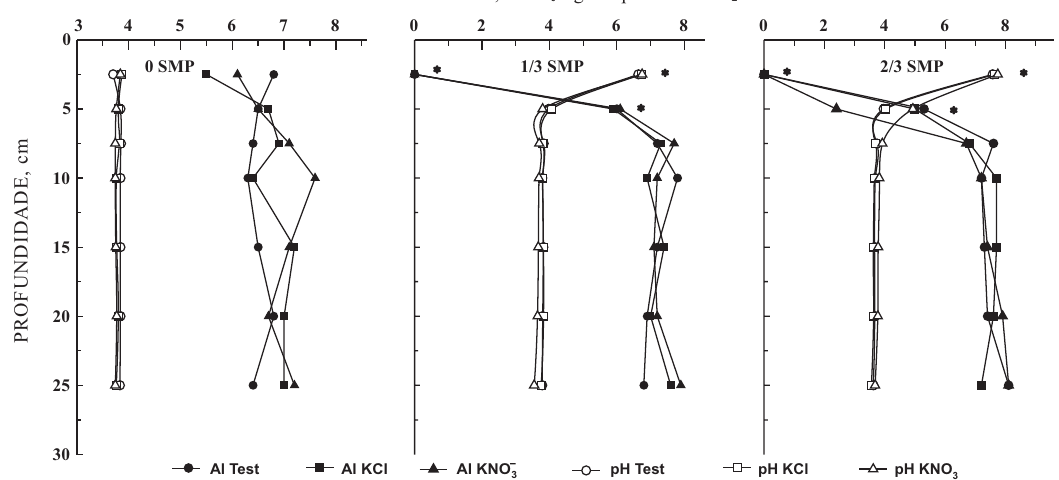
Figura 4. Valores de alumínio trocável e de pH-CaCl em colunas de um Cambissolo Húmico, em diferentes 2 profundidades, devido à aplicação superficial de doses de calcário (0, 1/3 e 2/3 da recomendação do método SMP para pH-H O 6,0) combinadas com sais de potássio, após 21 adições de água. Presença de 2 * ao lado da profundidade de cada atributo significa diferença estatística para a média dos sais de potássio dessa profundidade, em relação às médias das profundidades sem a existência de *, dentro da mesma dose de